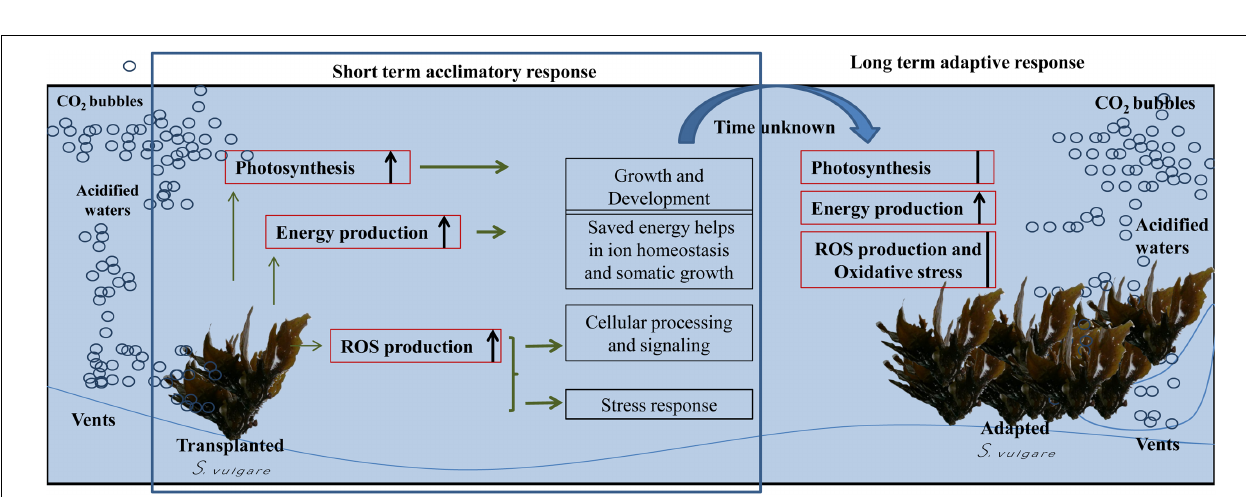
Frontiers in Plant Science |